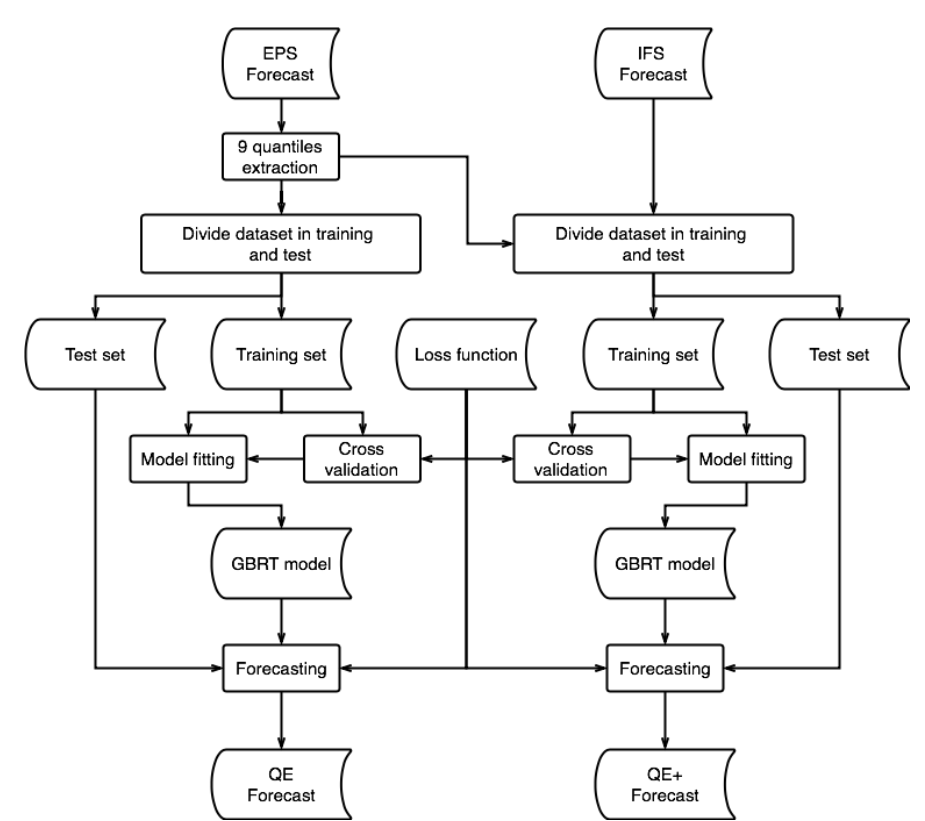
Figure 1. Flowchart showing the steps required to realize the QE and QE+ forecast starting from the EPS and IFS power